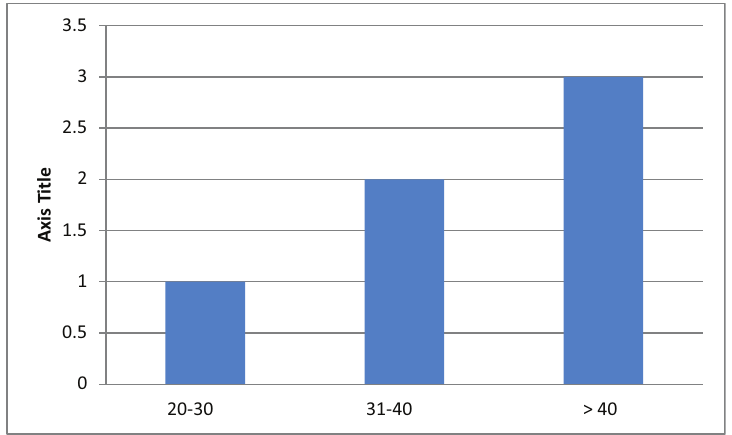
Figure 1 : Distribution of the study sample according to their age (yr), N = 47.